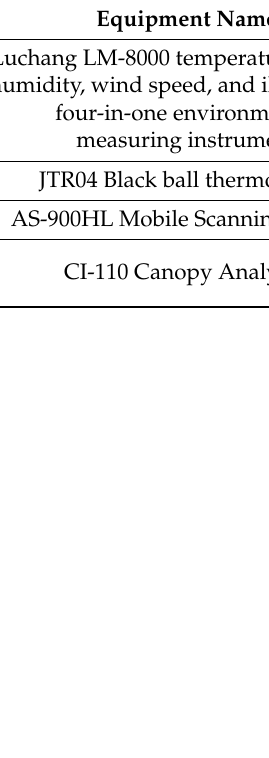
Figure 3. Statistics of key tree species in Zhumadian City. Table 1. Test equipment.